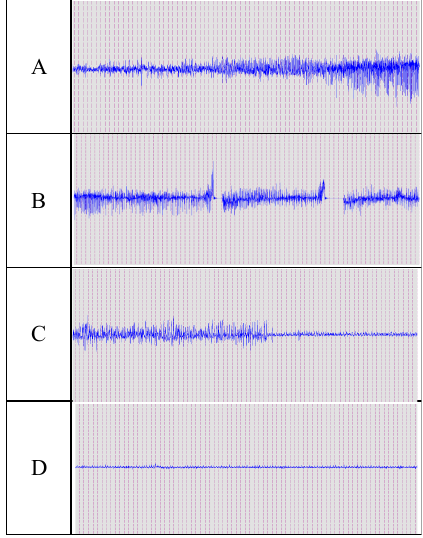
Figure 9. Example of midazolam control of PTZ-induced convulsion activity. The animal received an ED50 dose of MDZ/S or MDZ/NCs. ( A ) Gradually occurring convulsions. ( B ) Convulsions induced by PTZ. ( C ) The convulsion activity gradually stopped. ( D ) EEG after death of the animal. Calibration: 0.5 mV, 5 sec. Abbreviations: PTZ, pentylenetetrazole; EEG, electroencephalogram.